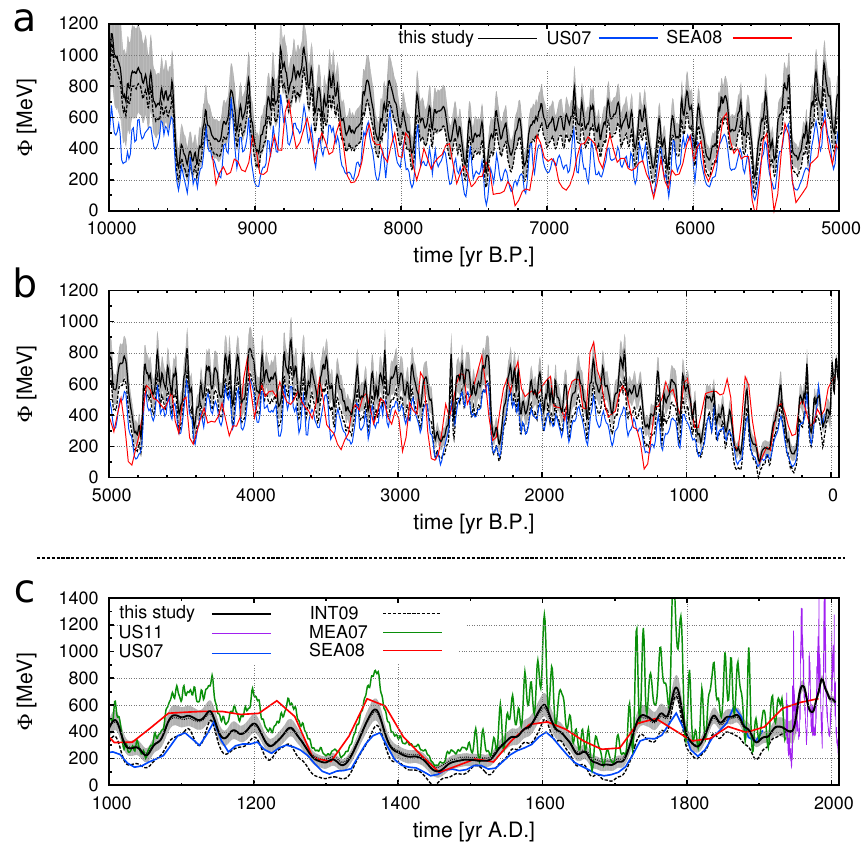
Fig. 12. (a, b) Solid black line and grey shading: solar modulation potential 8 (with 1 σ uncertainty) based on our new radiocarbon production reconstruction and the VADM history of Korte et al. (2011) using the production model of Masarik and Beer (1999). The dashed line shows 8 as calculated from the northern hemispheric record only (experiment INT09). The 8 histories of Usoskin et al. (2007) (US07, blue) and of Steinhilber et al. (2008) (SEA08, red) are additionally shown. For the last millennium (c) , we include the 8 record from Muscheler et al. (2007) (MEA07, green) as well as the instrumental data compiled by Usoskin et al. (2011) (US11, violet). The latter was used for normalisation and extension of our 8 reconstruction over recent decades. Note that all values of 8 are normalised to the LIS of Castagnoli and Lal (1980) according to Herbst et al. (2010). The dotted line in the lowest panel (usually not distinguishable from the solid line) shows 8 as calculated with the alternative production model of Kovaltsov et al.